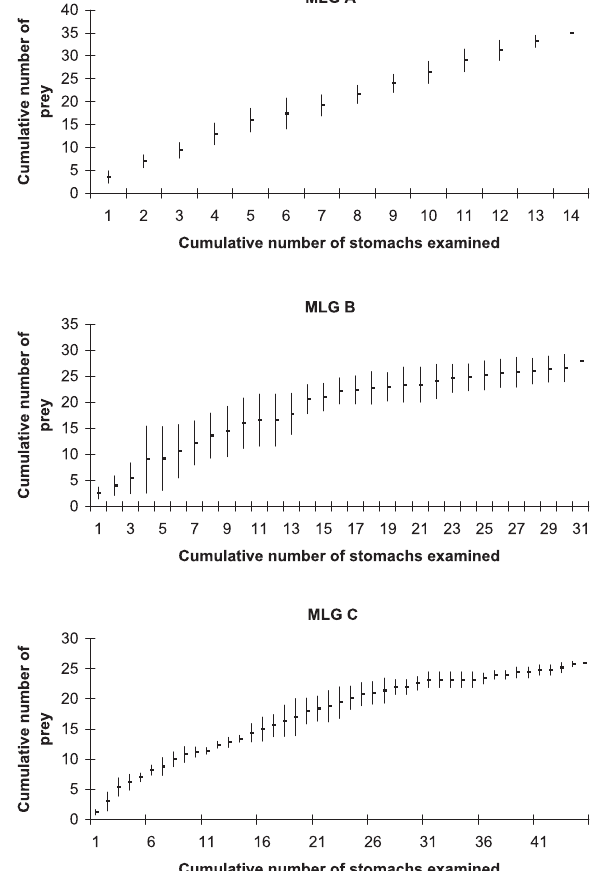
Fig. 3. – Cumulative prey curves for each major length group (MLg): a) 200-550 mm, B) 550-750 mm, and C) 750-1000